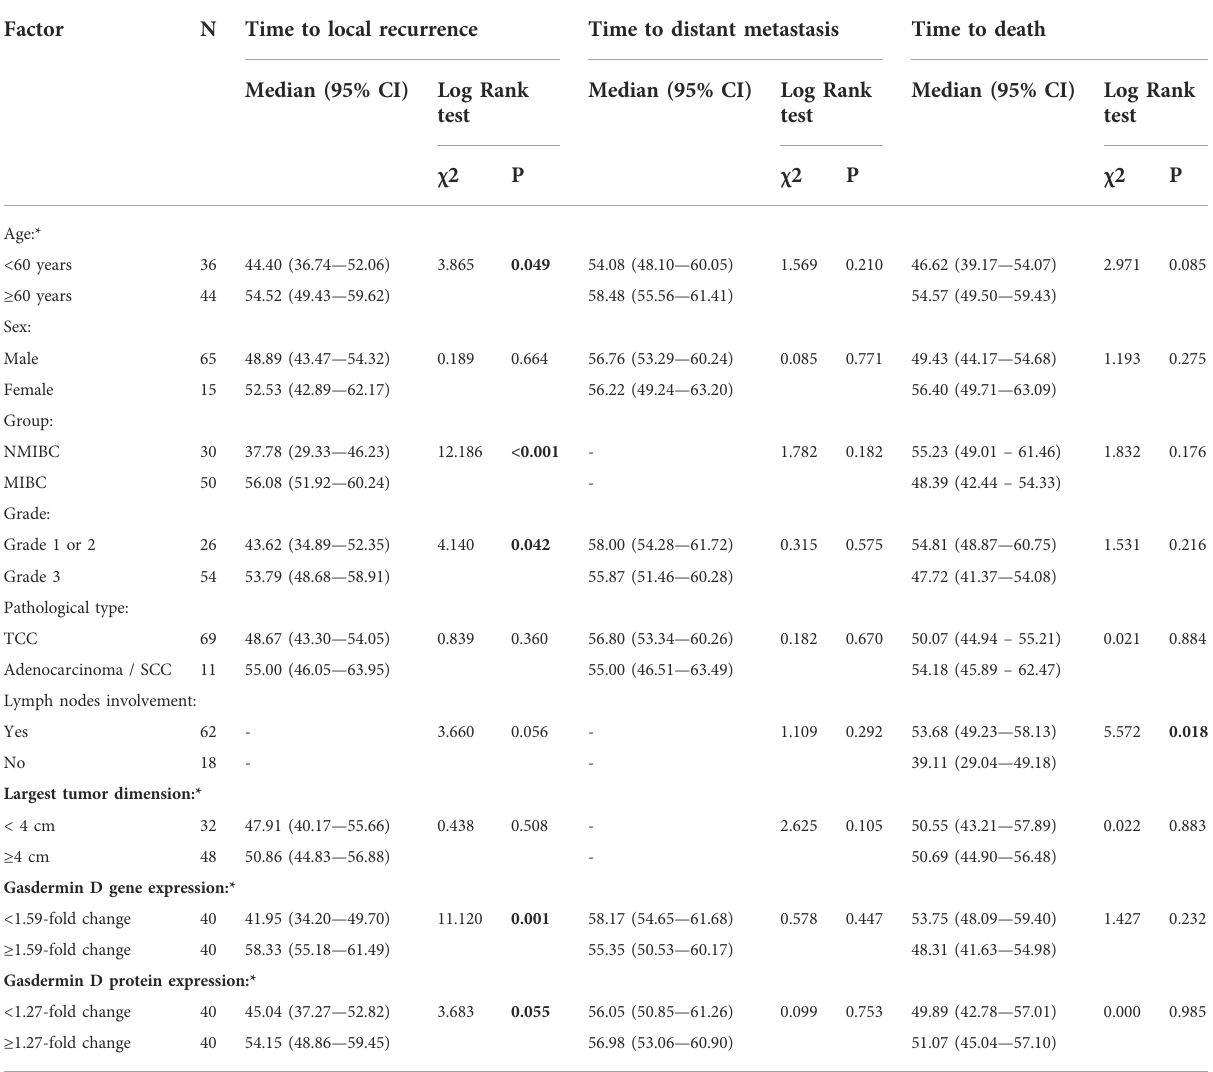
TABLE 9 Factors affecting overall survival: